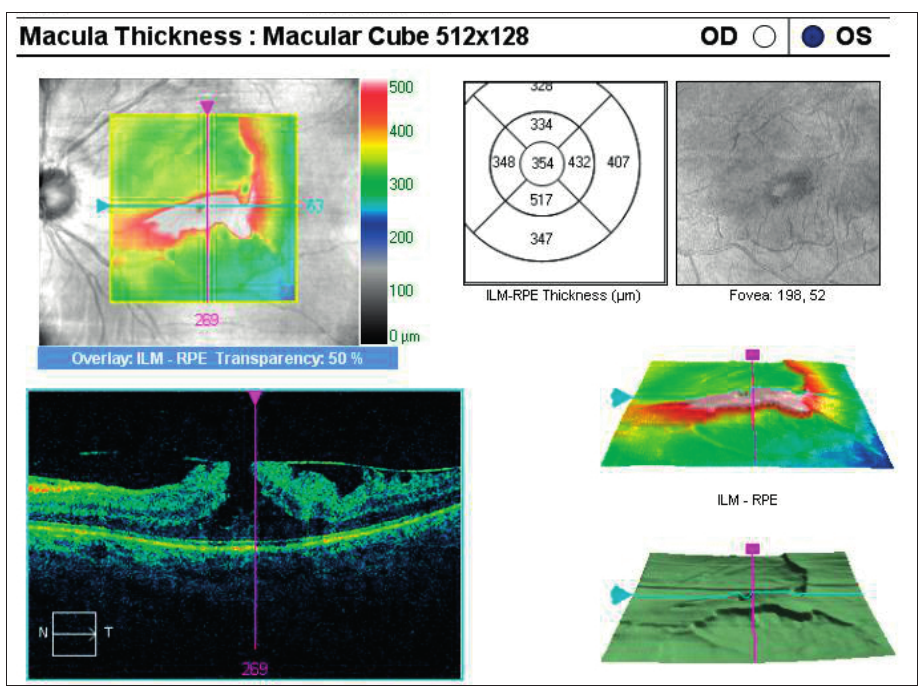
Fig. 4. Optical coherence tomography of the left eye: line of hyperreflectivity attached to the inner retinal surface, macular pseudohole and tangential vitreomacular traction.